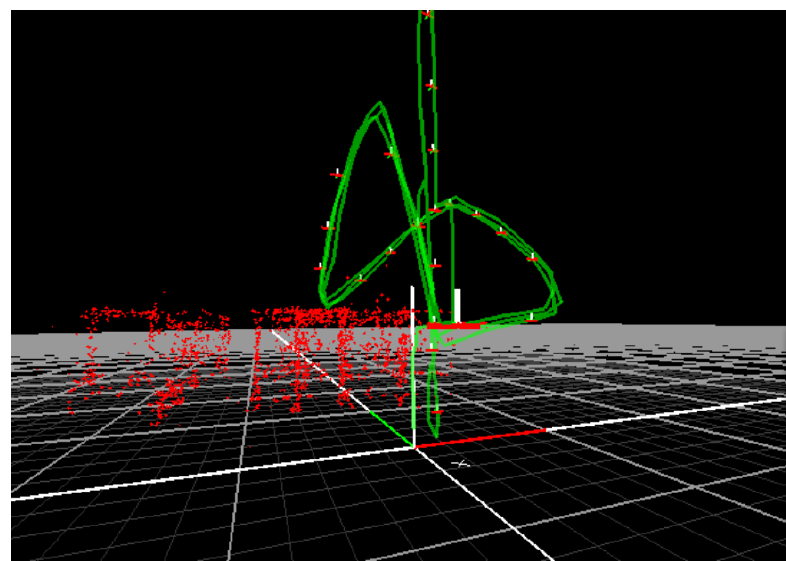
Figure 10. Parallel Tracking and Mapping (PTAM) output for the first trajectory. x , y and z axes are denoted red, green and white respectively. It can be seen that the quadrotor follows the reference correctly.